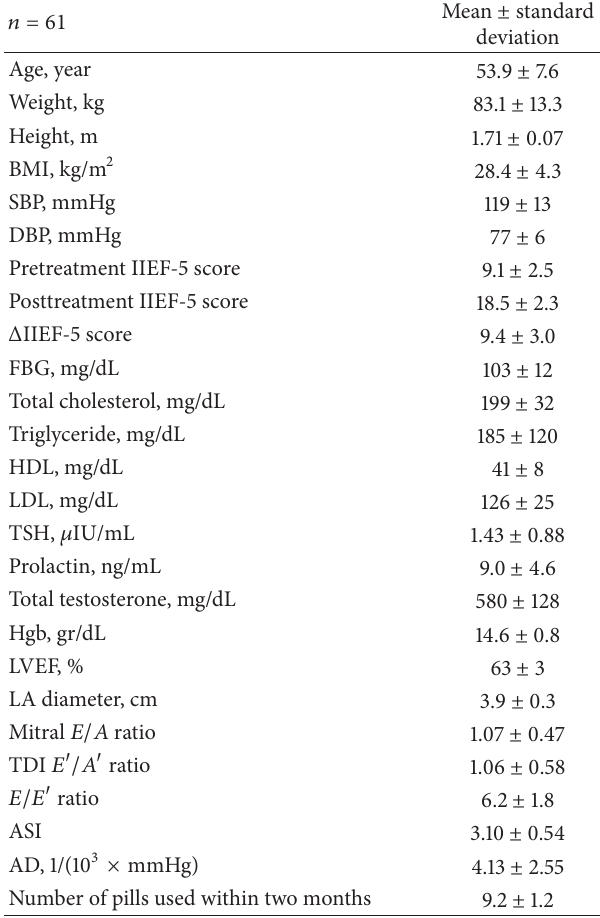
Table 1: Clinical, laboratory, and echocardiographic findings of the